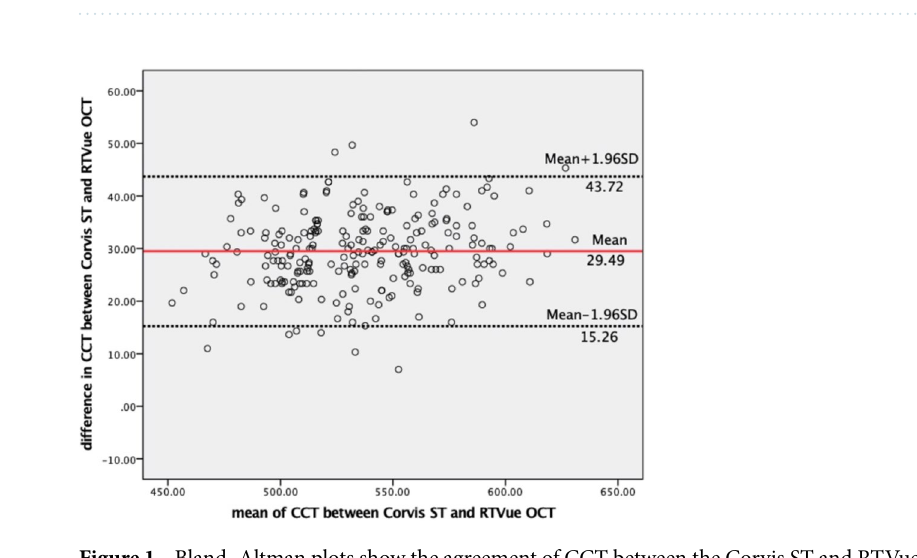
Table 1. Characteristics of the study subjects. SE spherical equivalent, Km mean K value, CCT(o) central corneal thickness by anterior OCT, CCT(c) central corneal thickness by Corvis ST, CCT(p) central corneal thickness by Pentacam HR. One-way ANOVA, post-hoc test of LSD was used, for age: P thin-normal = 0.001, P thin-thick = 0.011, P normal-thick = 0.086; SE: P thin-normal = 0.031, P thin-thick = 0.082, P normal-thick = 0.916; axial length: P thin-normal = 0.220, P thin-thick = 0.056, P normal-thick = 0.379; for axial length, Km and corneal diameter, All P thin-normal , P thin-thick , P normal-thick > 0.05; and for CCT(o), CCT(c) and CCT(p), All P thin-normal , P thin-thick , P normal-thick < 0.001. *Statistical significant (P < 0.05).